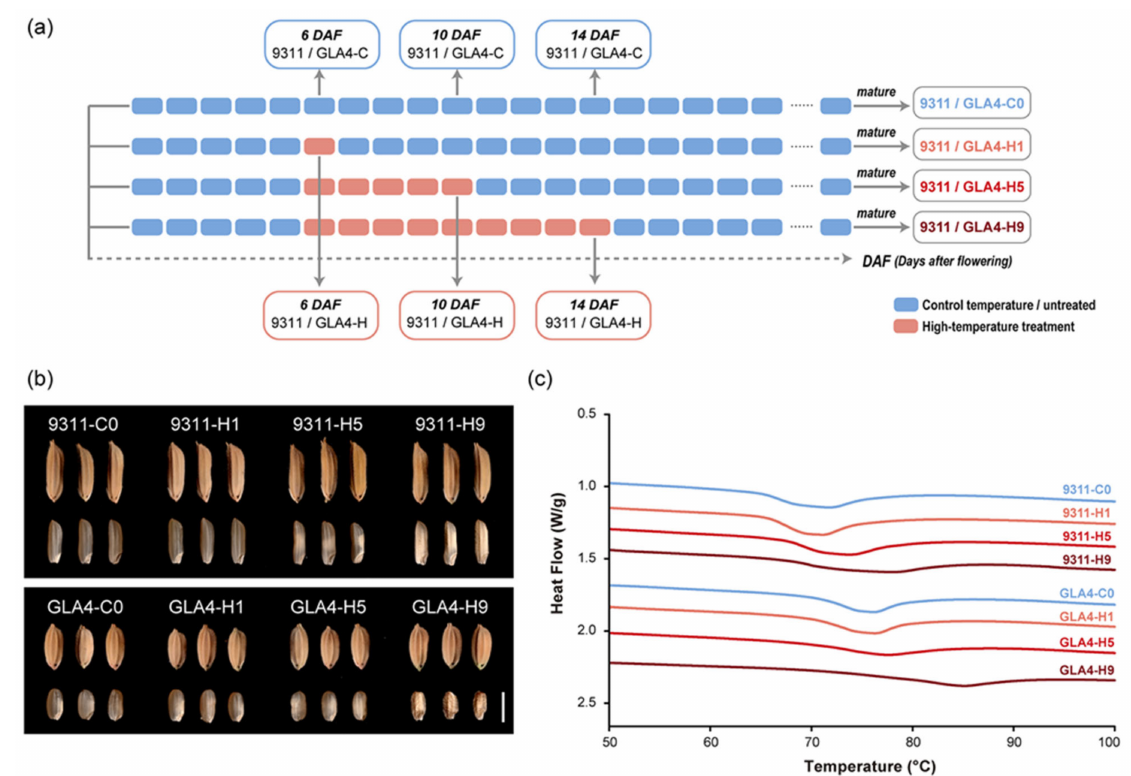
Figure 1. Effect of high-temperature stress on the rice grain. ( a ) Schematic diagram of the experimental design and sampling time points during the grain-filling period with high-temperature treatment. ( b ) Effect of three high-temperature treatments on grain morphologies of 9311 and GLA4. Scale bar = 5 mm. ( c ) Impact of three high-temperature treatments on DSC thermograms of 9311 and